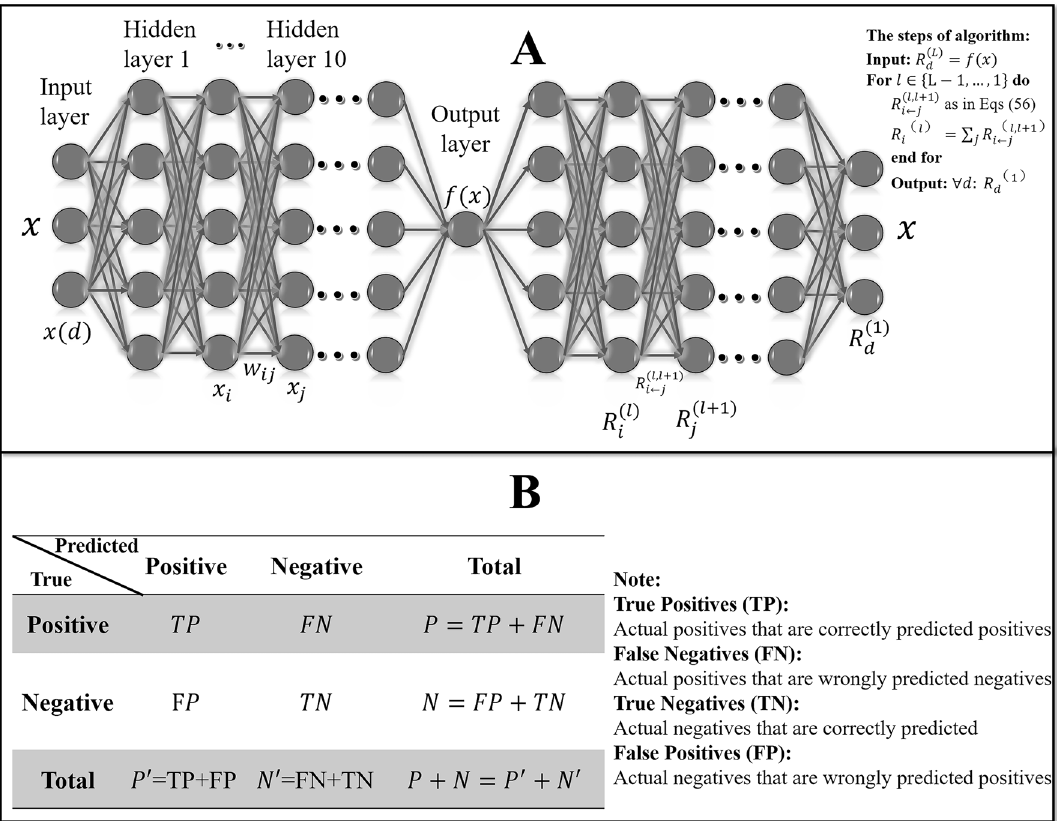
Figure 4. ( A ) A description of the neurons and weight connections of the DNN by the interpretation of the different variables and indices from multilayers. Left is the process of establishing f ( x ) by forward pass of DNN. ( 1 ) Right is the process of calculating relevance score R d by LRP back pass. On the upper right side is the algorithm summary about the complete LRP procedure for DNN. ( B ) A description of the confusion matrix of binary